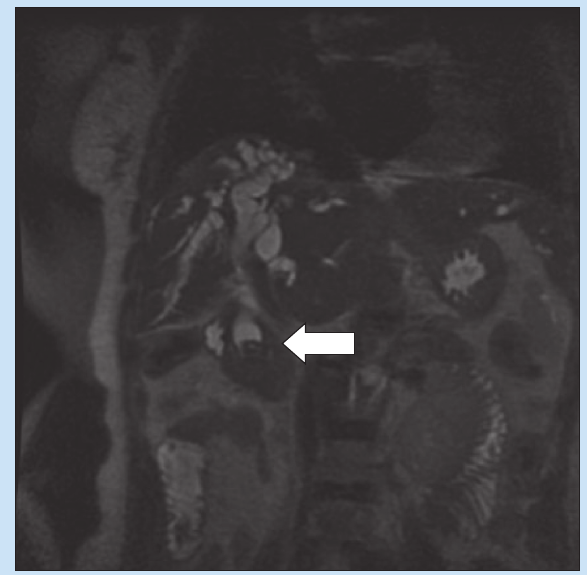
Fig. 1. Coronal single-shot fast spin-echo T2 MRI demonstrating a low- intensity stone (white arrow) impacted in the common bile duct.